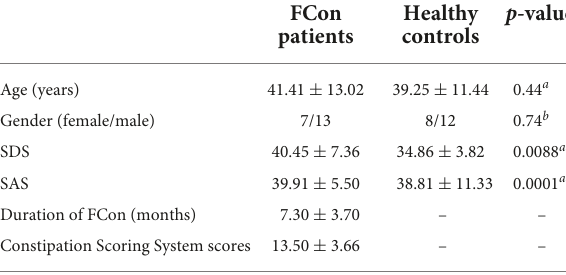
TABLE 1 Demographic and clinical information of the